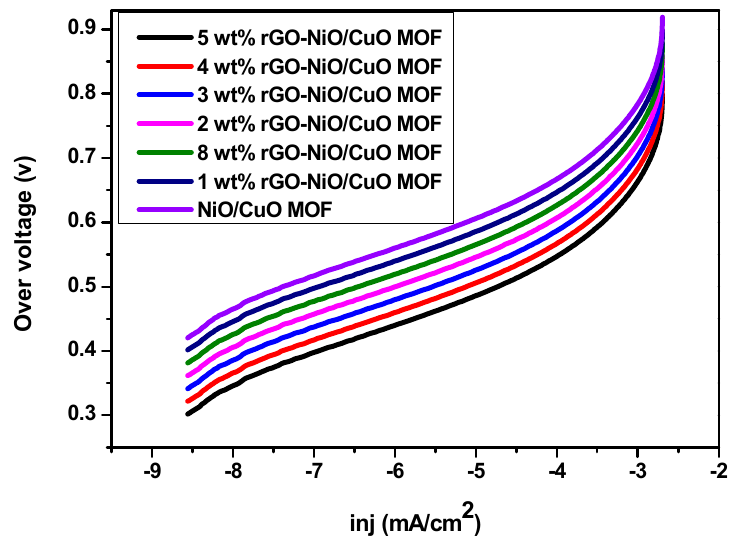
Figure 7. Tafel plots of NiO / CuO MOF and its composites 1 wt%, 2 wt%, 3 wt%, 4 wt%, 5 wt% and 8 wt% rGO in 3M methanol and 1M NaOH at 50 mV / s.